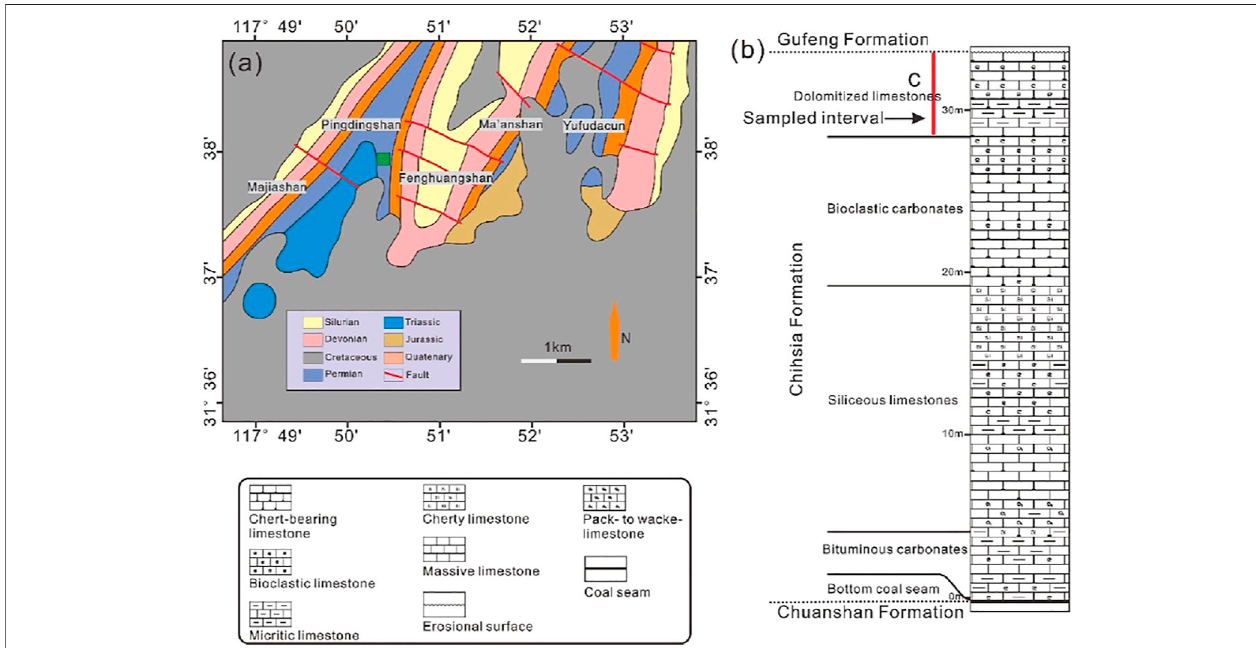
FIGURE 1 | (A) Local structural map showing tectonic characteristics of the Chaohu area. (B) Lithologic column showing petrofacies and sample location at the studied interval (modi fi ed after Liu et al., 2022).